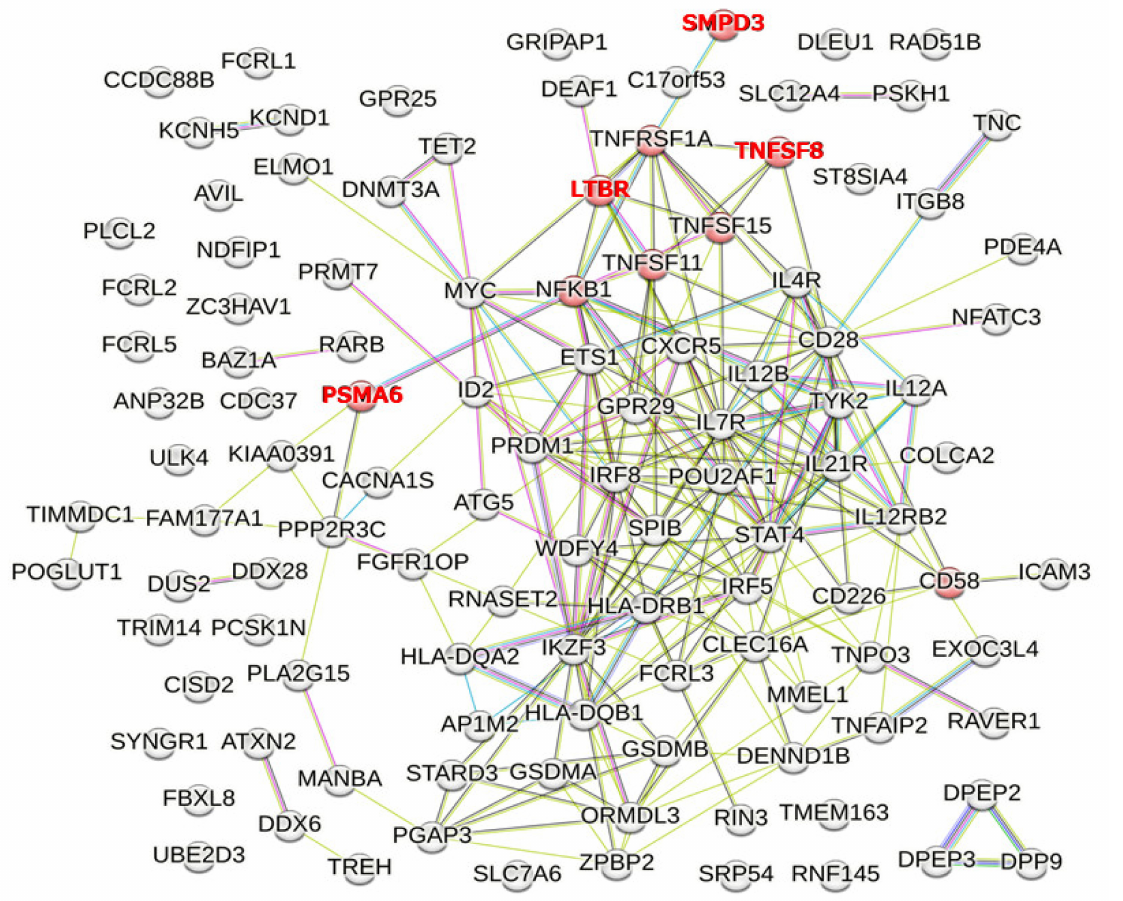
Figure 3. PBC susceptibility mapped genes and e-QTL genes whose protein products are involved in GO pathways related to “Cellular response to tumor necrosis factor.” Genes identified in the GO database as part of pathways associated with “Cellular response to tumor necrosis factor (GO: 0071356)” are shown as red nodes. However, after removal of “the e-QTL genes but not the mapped genes” (gene names shown in red), “Cellular response to tumor necrosis factor (GO: 0071356)” in the Gene Ontology database did not reach a level of statistical significance when using PBC susceptibility genes